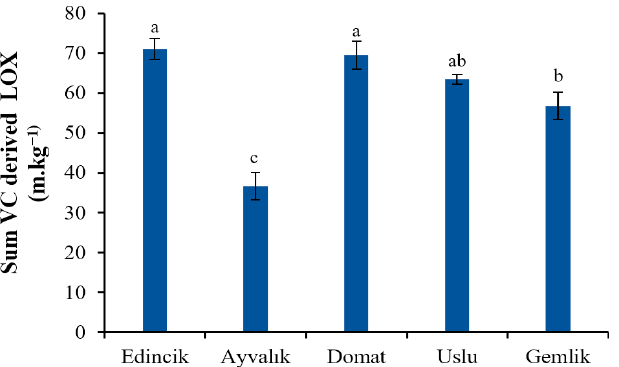
Figure 2. Total amount of VC derived by LOX in EVOOs from five Turkish olive cultivars. Different letters on the bars indicate significant differences between different oil samples ( p < 0.05).